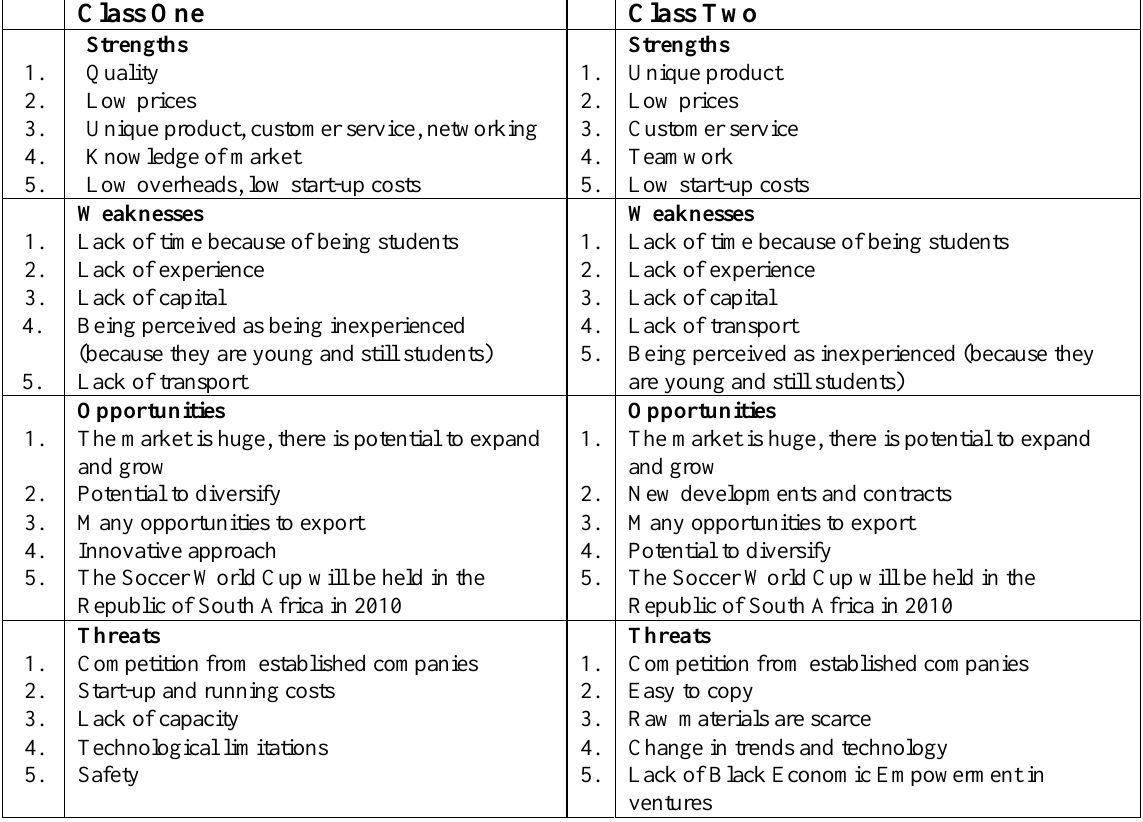
Table 2: Strengths, weaknesses, opportunities and threats: Class One and Class Two Class One Class